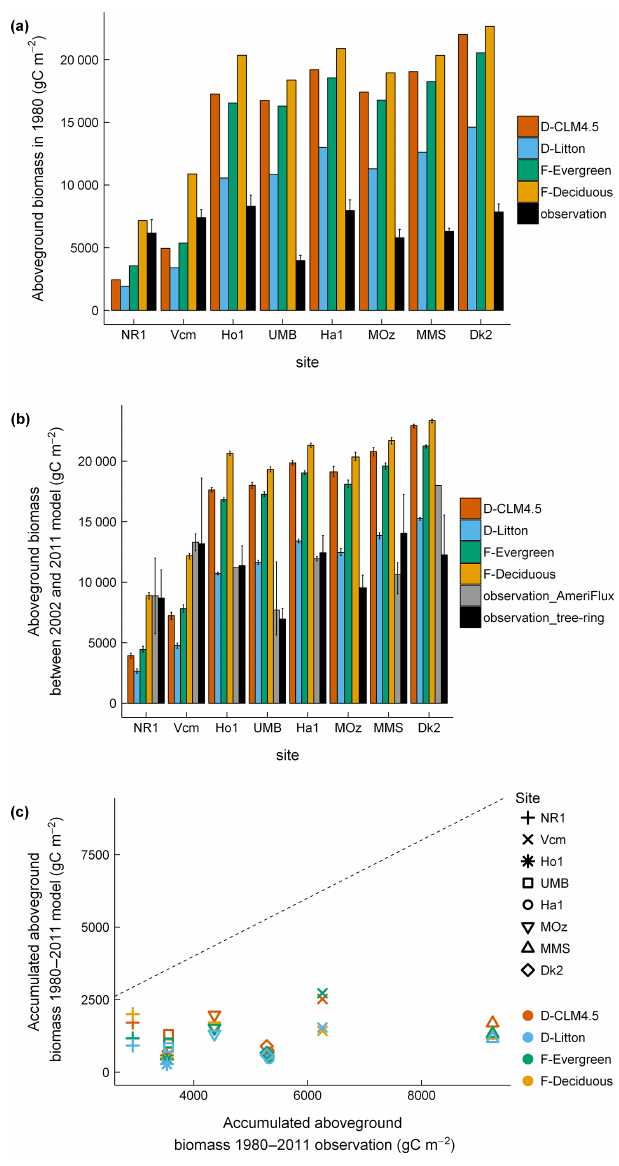
Figure 5. (a) Comparisons between observed and modeled above- ground biomass in 1980 for the four C allocation schemes. (b) Comparisons between mean observed and modeled above- ground biomass between 2002 and 2011 for the four C allocation schemes. (c) Comparisons between observed and modeled accu- mulated aboveground biomass 1980–2011 for the four C alloca- tion schemes. Turnover rate for stem in CLM4.5 is 2%. Dashed line is 1 : 1 relationship between observations and model. Obser- vations (“observation” in a , “observation_tree_ring” in b , and “ac- cumulated aboveground biomass 1980–2011 observation” in c ) are aboveground biomass estimates from tree-ring data, which are from Dye et al. (2016) for the Ha1 and Ho1 sites and following the methodology in Alexander et al. (2017) for the rest of sites. Obser- vations (“Observation_AmeriFlux” in b ) are aboveground biomass data from the AmeriFlux database, available only for a subset of sites and years (see Table 1).